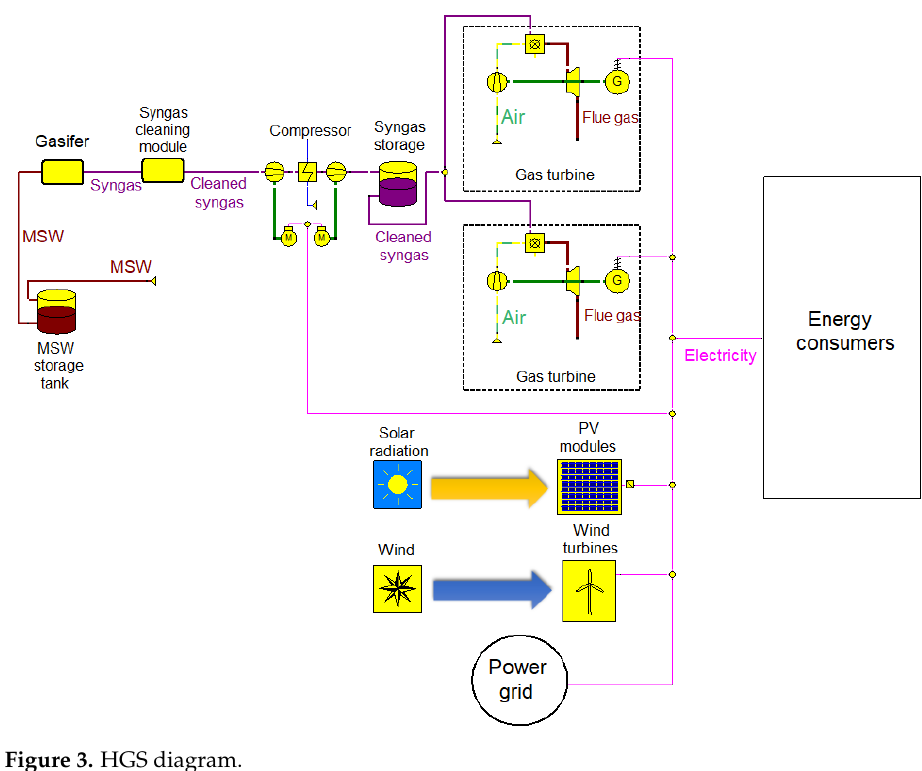
Figure 3. HGS diagram.